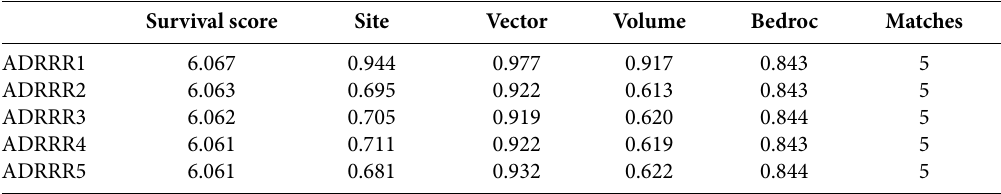
Table 2. Different parameter scores of the generated hypothesis ADRRR1. Survival